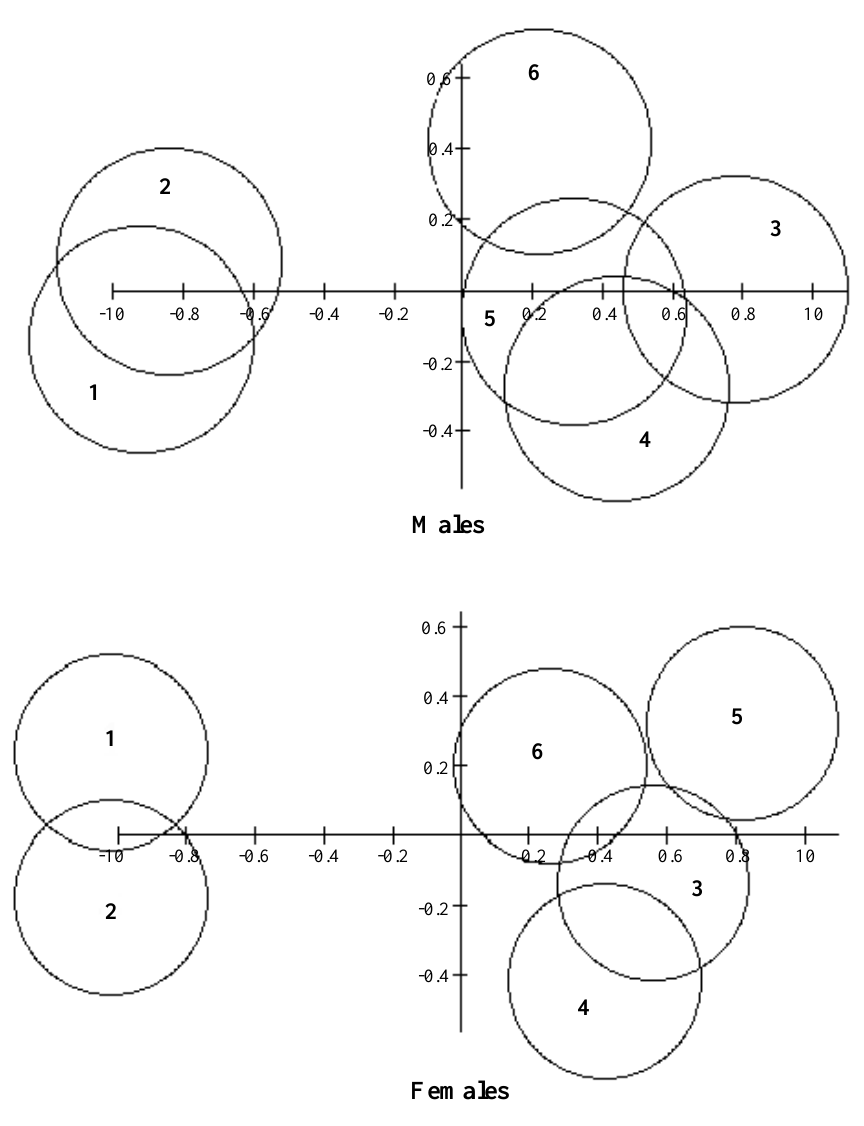
Figure 2 - Canonical representation of the characterized groups (1. Eureka 18ºC F F , 5. Eureka 18ºC F 2 populations (Eureka and Davis) the group 18ºC F